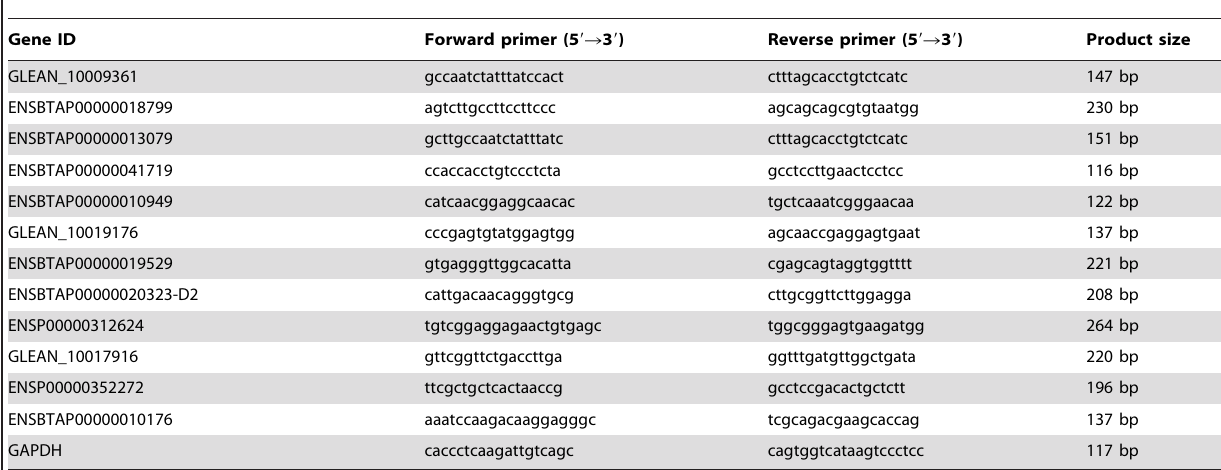
Table 1. Primer sequences for qRT-PCR amplification of specific genes.